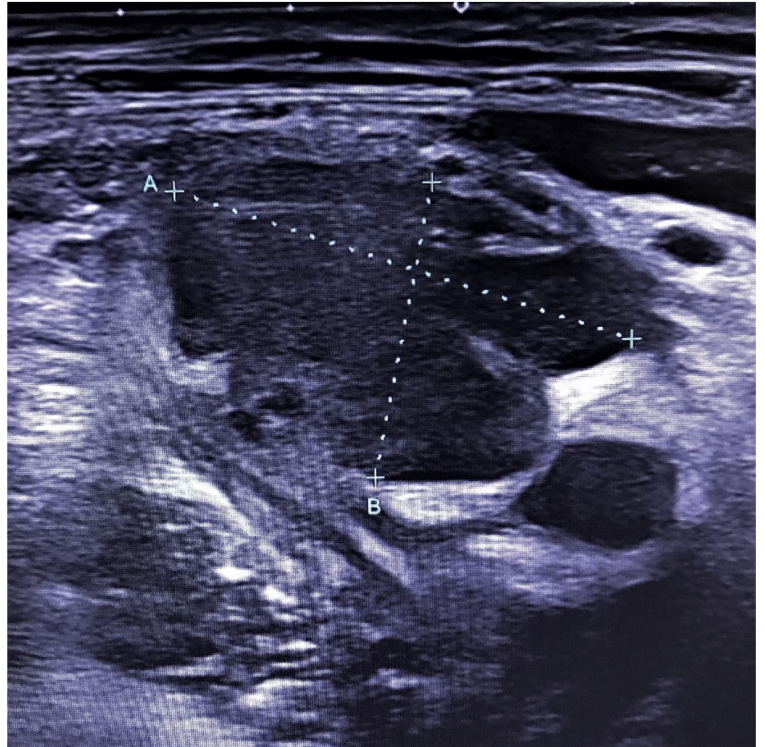
Figure 1. Ultrasound of the deep right iliac lymphadenopathy (lymph node size: A 40 mm, B 28 mm). A 64-layer total-body computed tomography scan was performed, after administration of positive oral contrast medium (Gastrografin), as well as before and after intravenous administration of an iodinated contrast agent. The exam showed an axillary lymph node (maximum diameter 5 × 15 mm) with inflammatory aspect, few mesenteric 6–10 mm lymph nodes with reactive nonspecific aspect and confirmed the presence of a 45 × 29 mm iliac hyperaemic lymphadenopathy associated with homolateral inguinal lymphadenopathies (maximum size 5 × 10 mm) (Figure